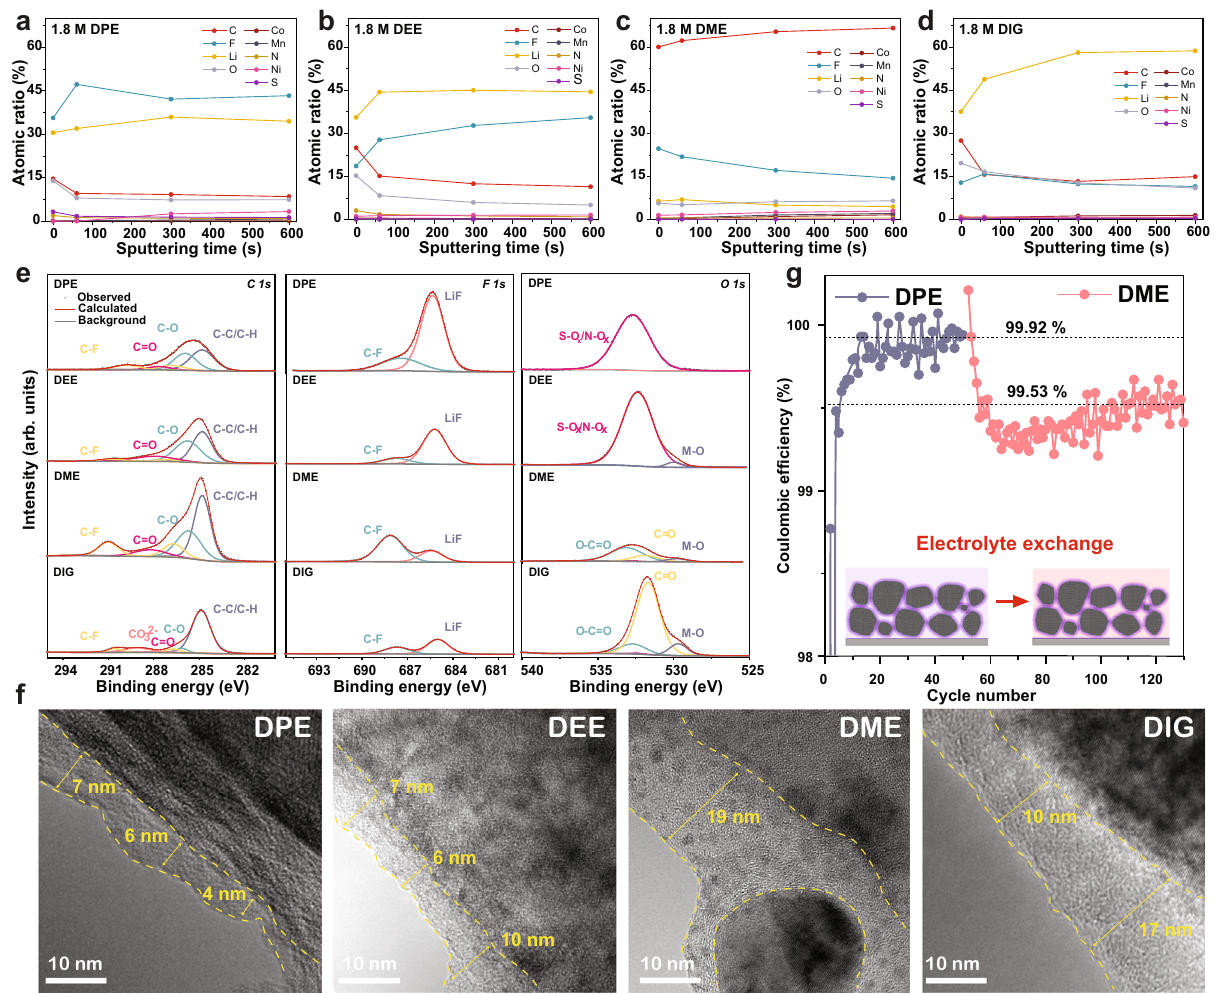
Fig.3|CharacterizationsofthepositiveelectrodeCEI. Allthecellswerecycledin the 1.8M LiFSI electrolytes with different ether solvents at 0.48mA/cm 2 and 25°C. a – d XPS analyses of the depth-dependent elemental concentration on fully dis- charged NCM811 cathodes after 100. e XPS Fine spectradeconvoluting analyses of C 1s , F 1s , and O 1s signals. f High-resolution TEM imaging of CEI layers on cycled